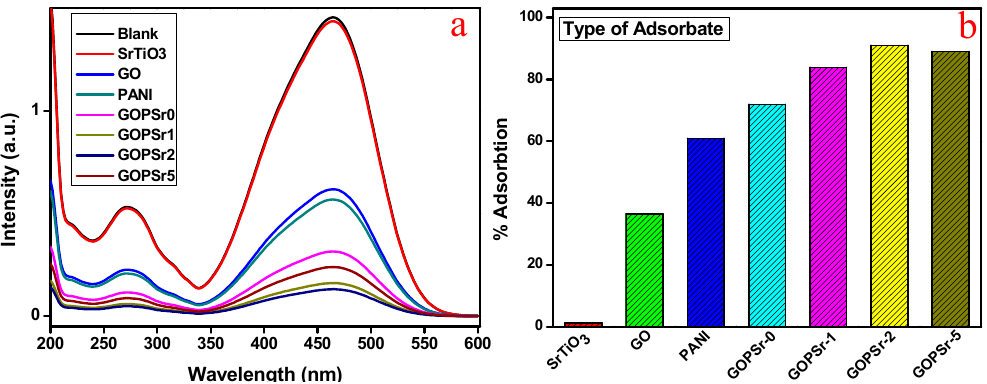
Figure 6. ( a ) UV-vis absorption spectra of MO aqueous in the presence of various adsorbents and ( b ) percentage removal of MB in the presence of various adsorbents (initial MO concentration: 20 mg·L − 1 ; amount of adsorbent: 0.5 mg·mL − 1 ; pH 7; time: 30 min; at room temperature).